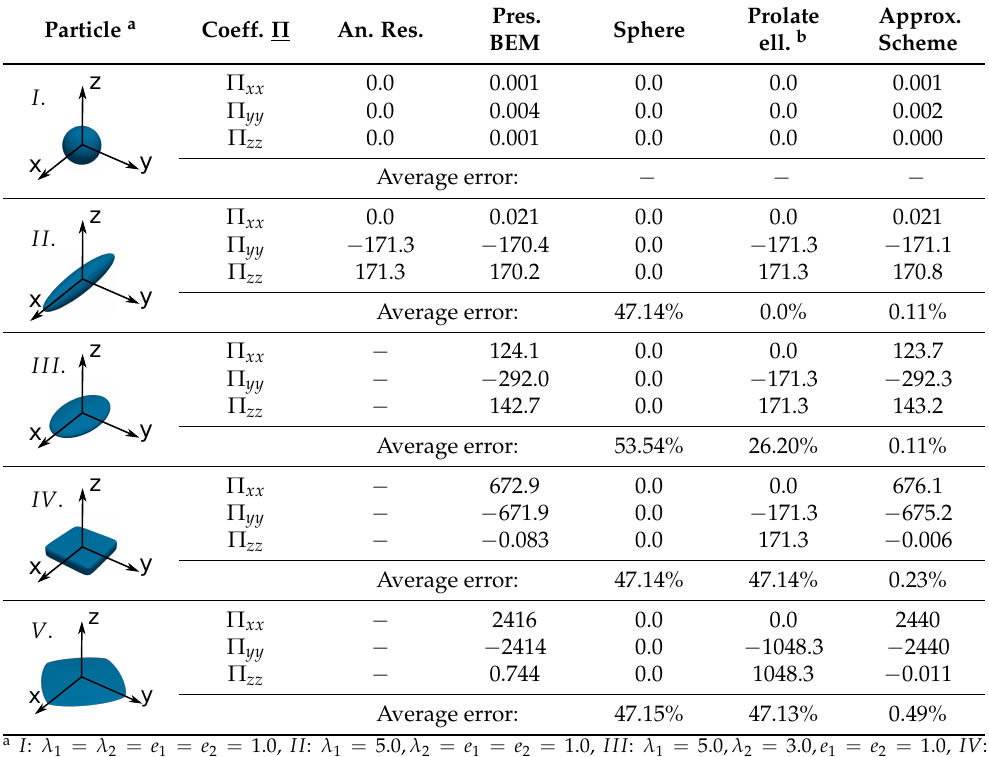
Table 4. Π tensor coefficients are determined for particles I – V , using different methods. First, the analytical result is presented for the considered particle (applies only for particles I and II ). In the next column, a direct result from the present BEM code is presented. This is followed by the results obtained analytically with two simplified particle representations, namely the sphere and the prolate (considering λ 1 of the particle). In the last column, the result of the derived approximation scheme is shown. Particle a Coeff. Π An. Res.